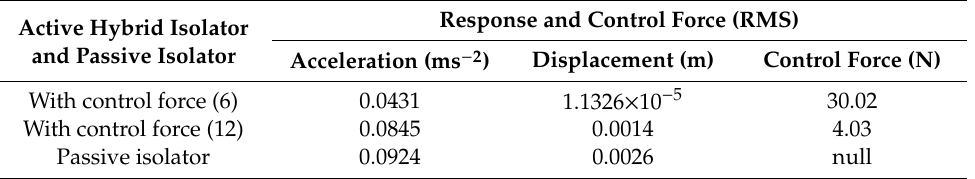
Figure 5. The displacement and acceleration responses of the passive isolator with QZS for the nominal parameter values ( a , b ). Table 1. RMS comparison of responses with the nominal parameters of the isolator.